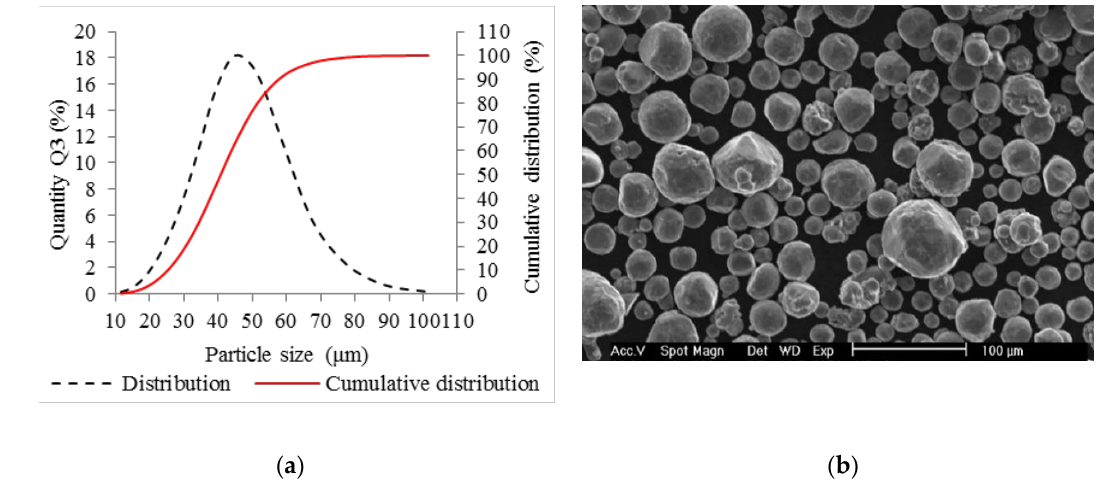
Figure 1. Selective laser melting (SLM) powder characteristics; ( a ) chart of particle size distribution; ( b ) shape of powder particles (scanning electron microscopy (SEM)).